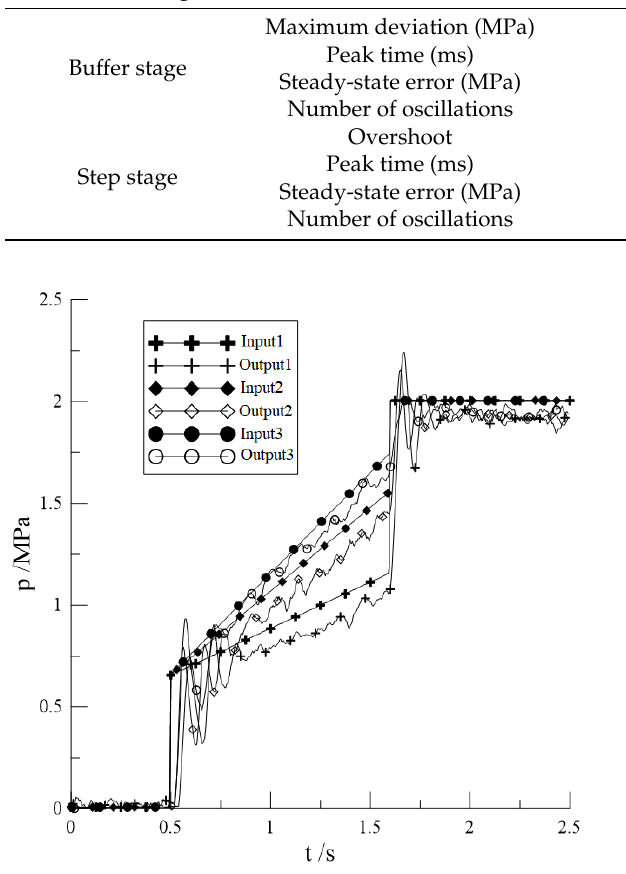
Figure 11. The 2D digital buffer valve’s buffer following the characteristic curve.